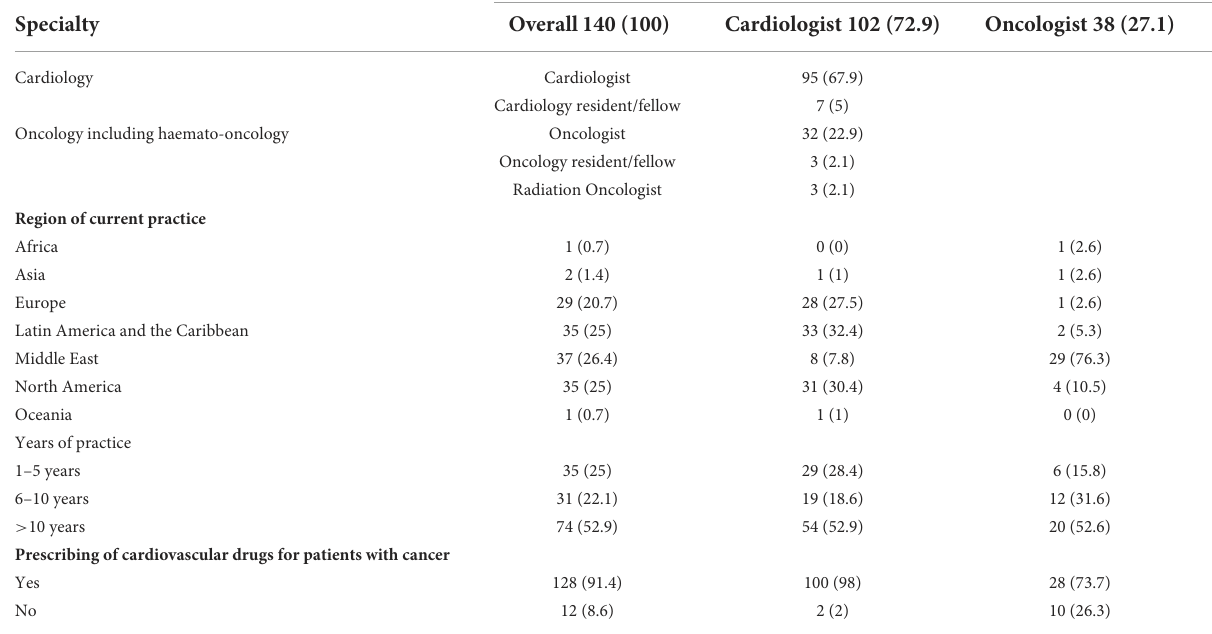
TABLE 1 Demographics of the survey